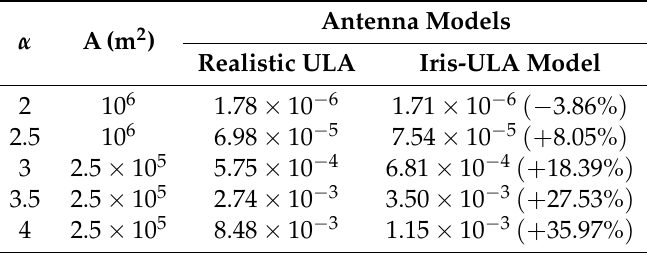
Table 7. Critical node density ρ c with the ULA antenna and the iris-ULA model when σ = 4.